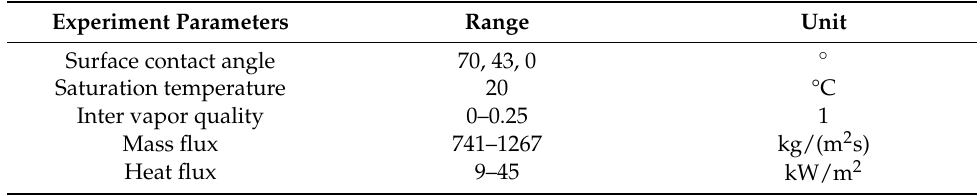
Table 2. Operating condition for single